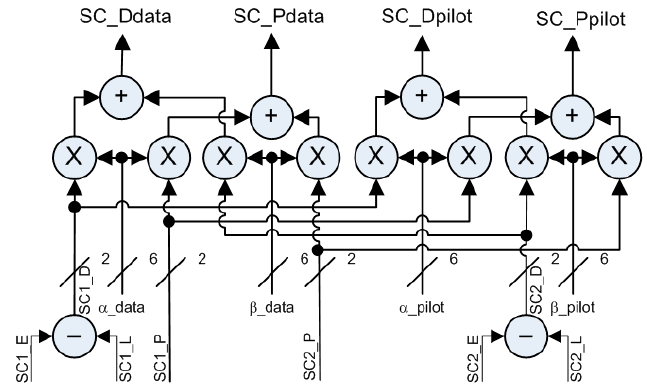
Figure 3. MBOC Sub-Carriers Multi-Bit Simplification and Combination of both Data and Pilot Components (Differential = Early − Late; Prompt)